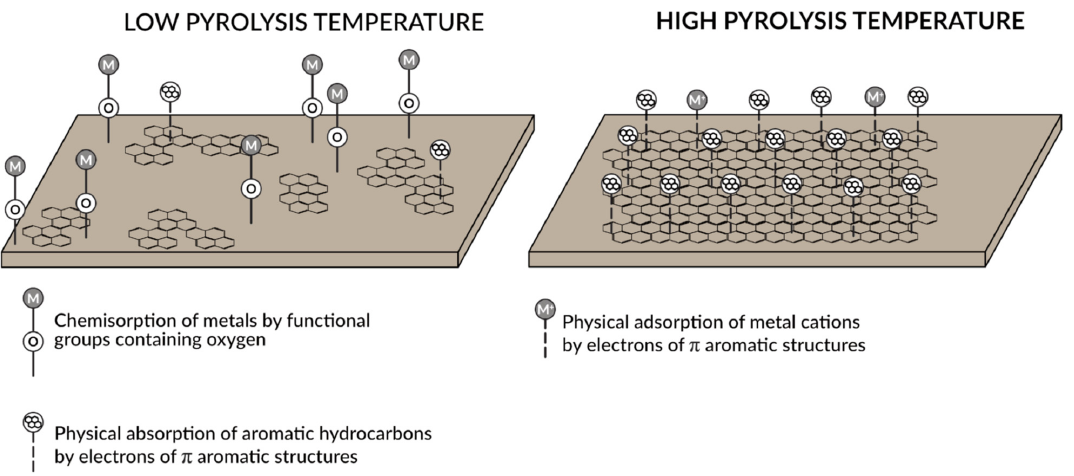
Figure 5. A schematic diagram showing the mechanisms of sorption of organic and inorganic pol- lutants on biocarbons produced at high and low temperatures [48],